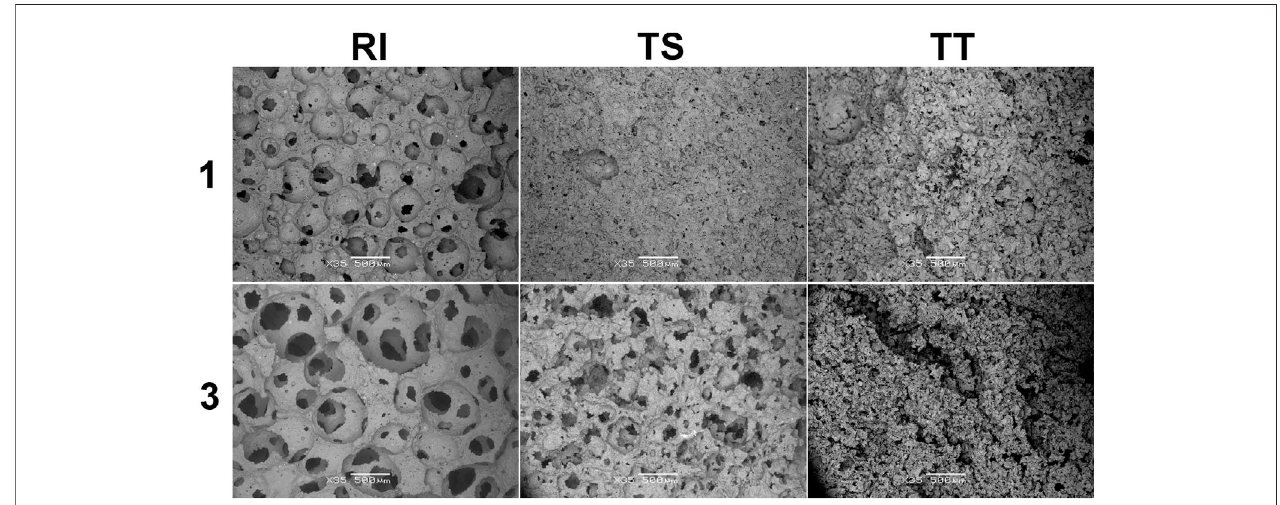
FIGURE 11 | Region of interest of the analyzed alkali-activated foams cured at 1,000 ° C (RI, TS, and TT fl y ash used, 1, 2, and 3 represent the amount of foaming and stabilizing agent added) presenting grayscale image and the biggest main pores. Colors correspond to a range of size classes with respect to EqDiameter, purple (0.85 – 1 mm), green (1 – 1.6 mm), and yellow (more than 1.6 mm).